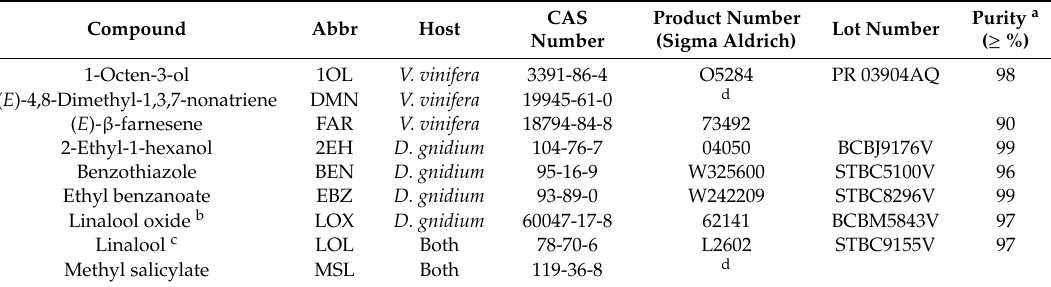
Table 2. Plant stimuli for electroantennogram (EAG)